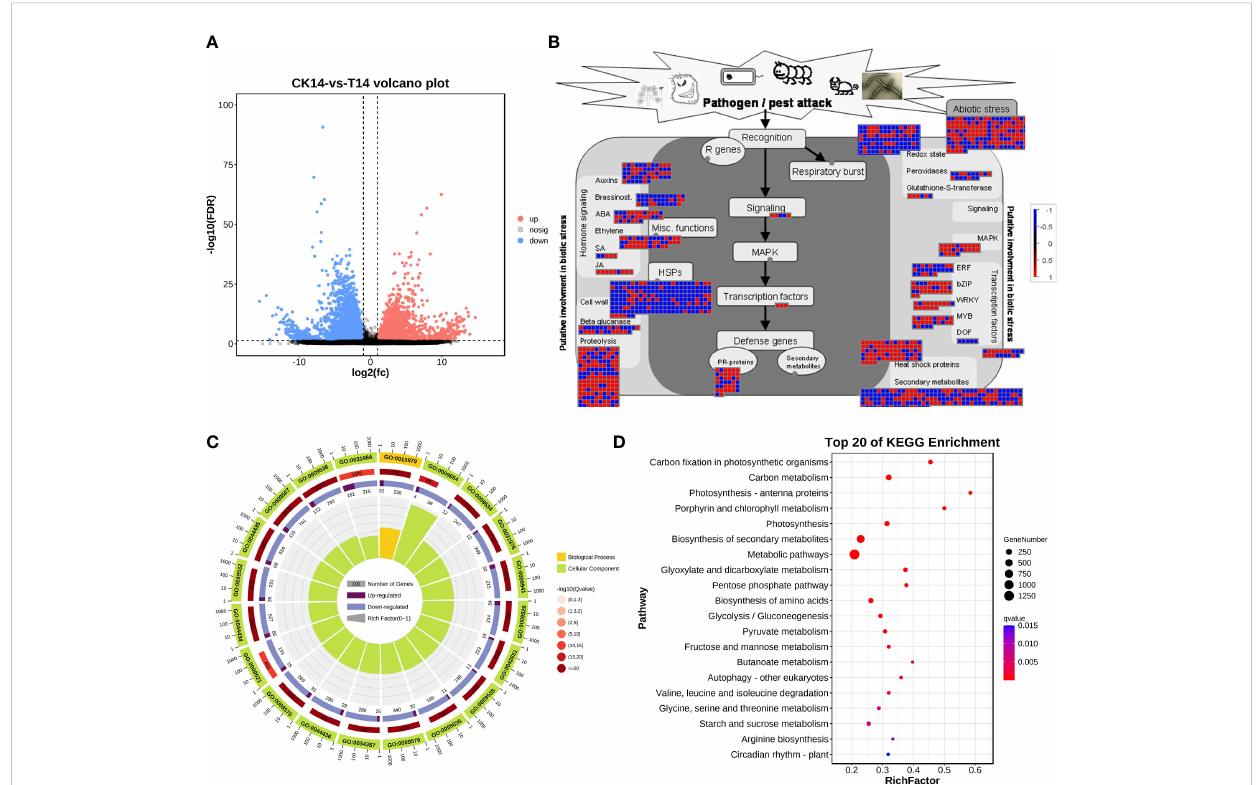
FIGURE 3 TSWV virus induced dramatic responses relevant to biotic stress in Nicotiana benthamiana at 14 days post inoculation. (A) Volcano plot of DEGs, which compares the levels of gene expression between CK and T14. Blue dots indicate downregulated genes, and red dots represent upregulated genes. (B) MapMan visualization of the biotic responses of N. benthamiana to the TSWV virus at 14-day inoculation. Upregulated and downregulated genes are shown in red and blue, respectively. The scale bar represents fold-change values in the CK14 vs. T14 comparison. (C) Gene Ontology classi fi cation of the DEGs from the CK14 vs. T14 comparison in N. benthamiana according to the GO groups based on molecular function, biological process, and cellular component. (D) Pathway classi fi cation of the DEGs from the CK14 vs. T14 comparison in N. benthamiana . The number of genes in each pathway is represented by the plot size. The plot color indicates the signi fi cance differences of each